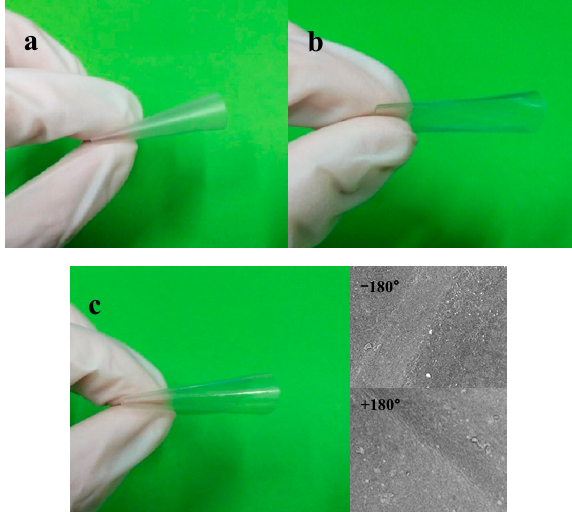
Figure 7. Flexibility of ( a ) neat ANFC film, ( b ) neat ABPE-10 film, ( c ) ANFC/ABPE-10 composite film (68% ANFC) and the scanning electron microscopy (SEM) images of ANFC/ABPE-10 composite film (68% ANFC) folded to − 180°and +180°.